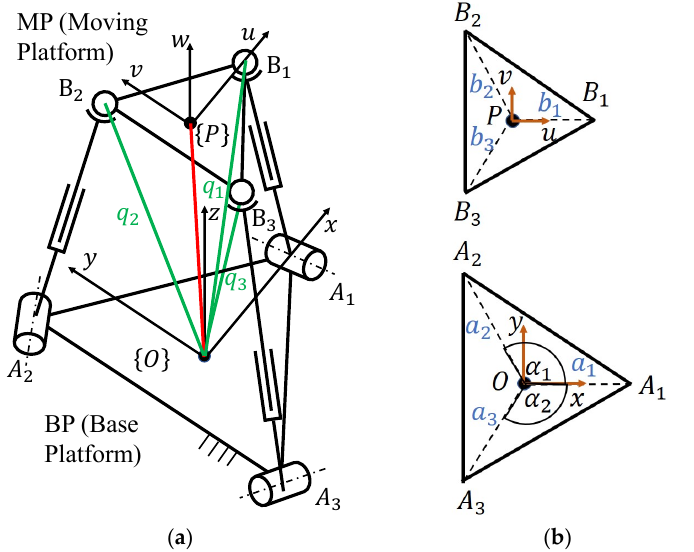
Figure 1. The kinematic diagram of the 3-RPS parallel robot: ( a ) analytical model of 3-RPS robot and ( b ) analytical model of BP and MP.